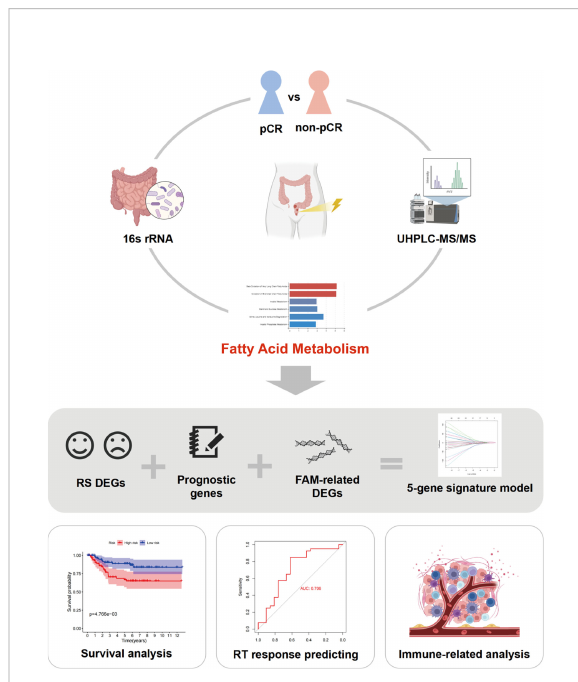
FIGURE 1 Work fl ow of this study. pCR, pathological complete response; UHPLC-MS/MS, ultra-high performance liquid chromatography – tandem mass spectrometry; RS, radiation sensitivity; FAM, fatty acid metabolism; RT,